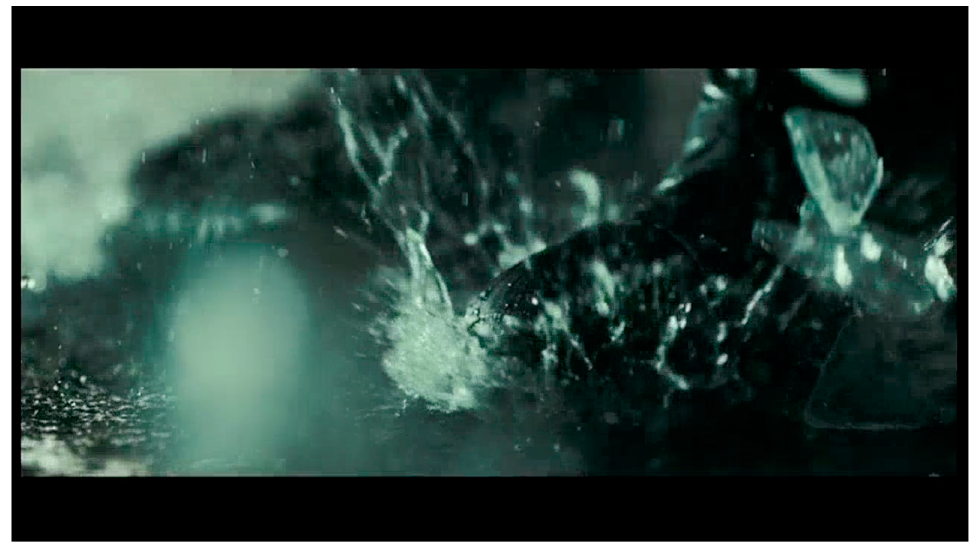
Figure 17. Lines of force ricochet across the frame in a kaleidoscopic spray. Frame capture, The Grandmaster (Wong 2013).